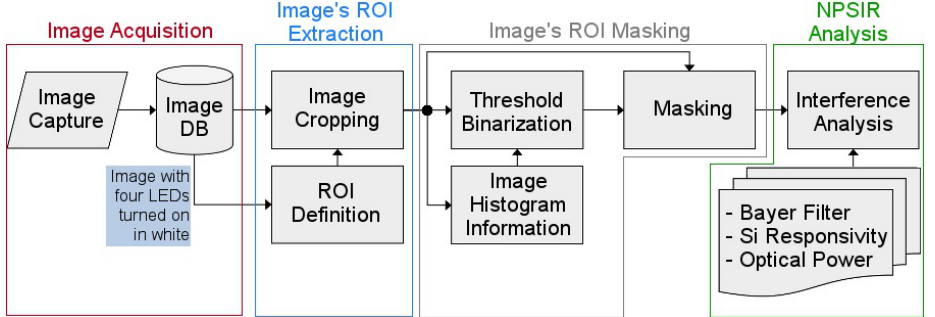
Figure 7. Optical Interference Experiment Methodology